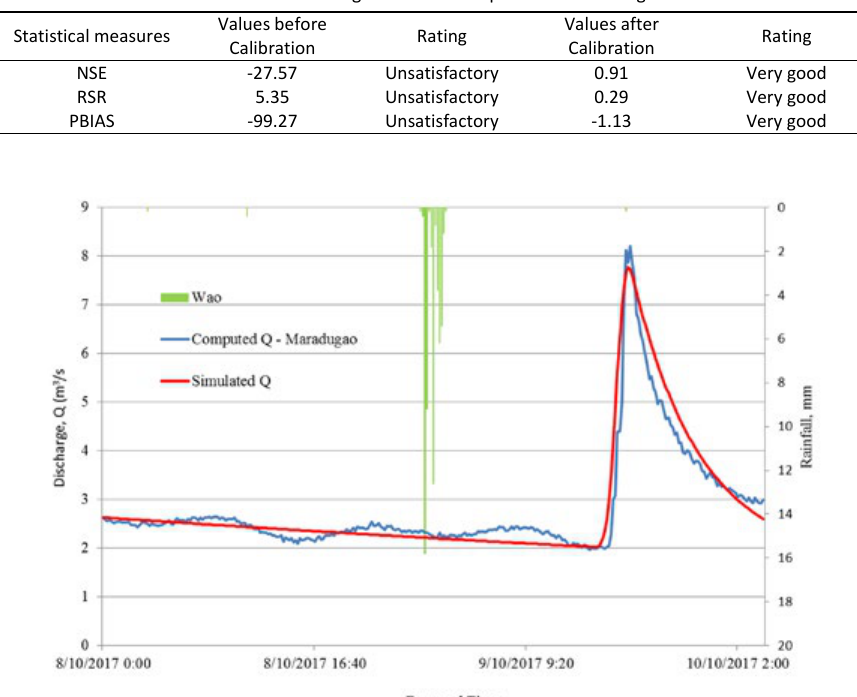
Fig. 2: Comparison of simulated and observed discharge with rainfall data